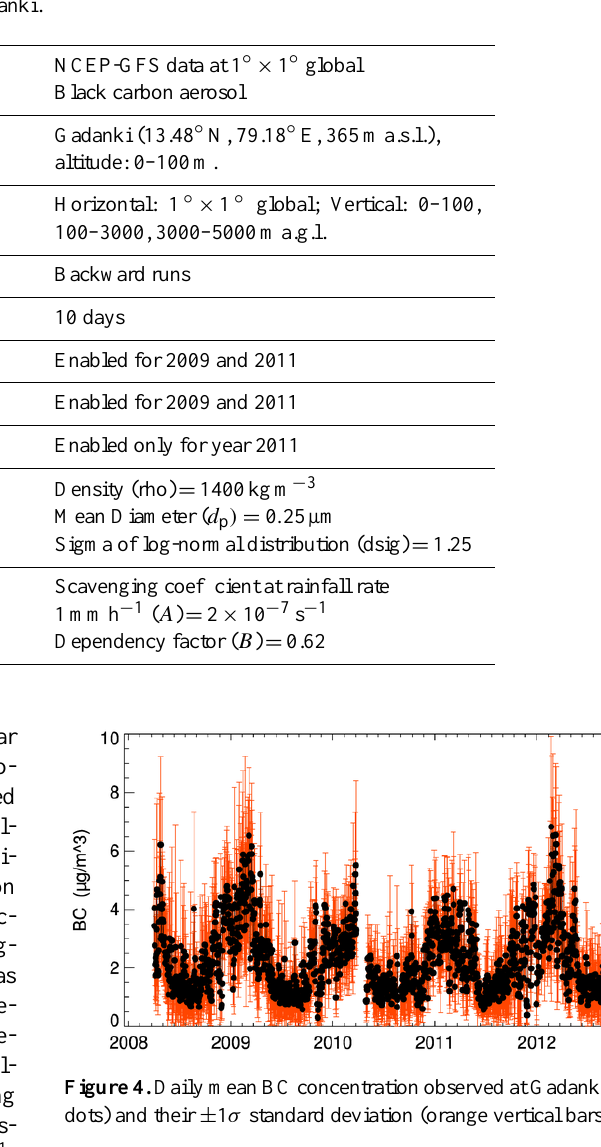
Table 1. FLEXPART model set-up for retroplume runs from Gadanki.